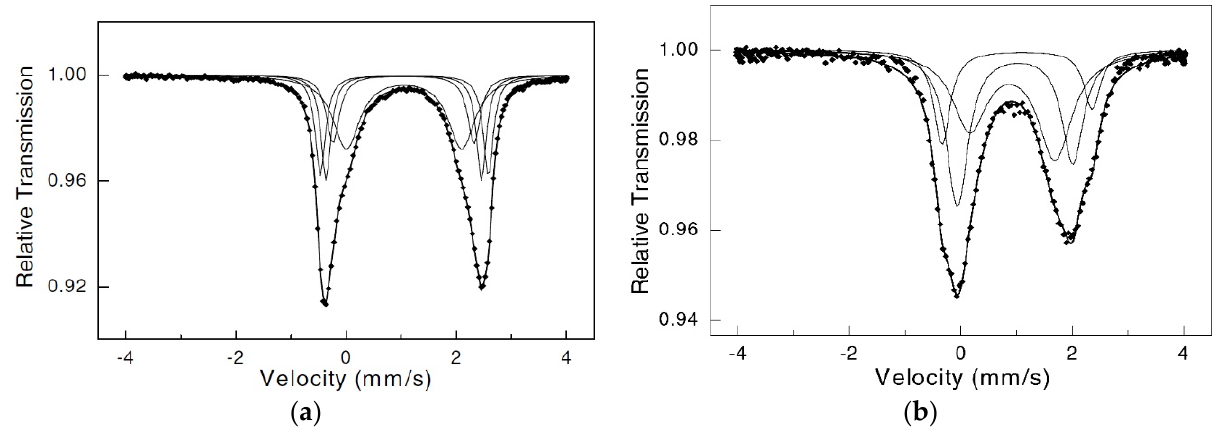
Figure 4. Comparison of the room temperature Mössbauer spectra of the bulk ( a ) and glass ( b ) materials from D’Orbigny angrite. Indicated spectral components are the results of the fits. Adapted from [11].